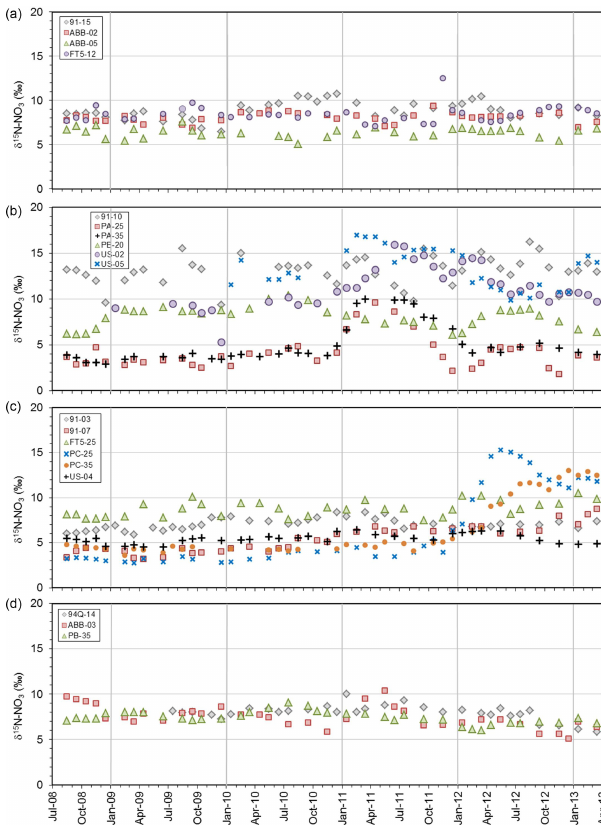
Figure 5. δ 15 N-NO 3 time series plots: (a) no trend – stable (SD< ± 1 . 0), (b) no trend – variable (SD> ± 1 . 0), (c) enrichment trend, and (d) depletion